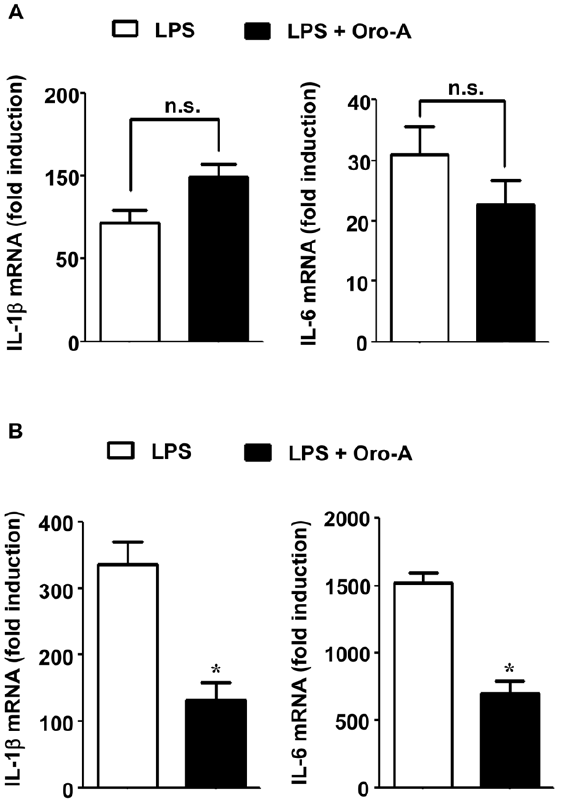
Figure 4. Effects of oroxylin A on LPS-induced expression of IL- 1 b and IL-6 in BV-2 cells. BV-2 cells (5 6 10 4 cells/well) were co-treated with LPS (100 ng/ml) and oroxylin A (Oro-A, 50 m M). Effects of oroxylin A on LPS-induced increase of IL-1 b and IL-6 mRNA were determined in ( A ) 1 hour and ( B ) 20 hours by real-time RT-PCR. Results are expressed as fold increase of target mRNA relative to the mRNA level in 0 hour, and are mean 6 SEM from three independent experiments. n.s., not significant, compared with LPS-treated cells. * , p , 0.05, Student’s t-test compared with LPS-treated cells.